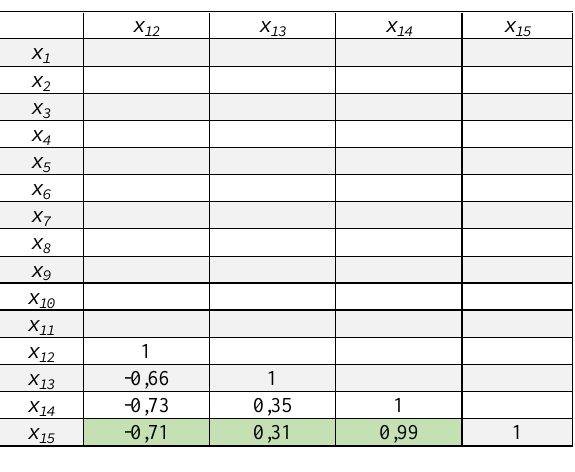
Table 2. Correlation coefficient